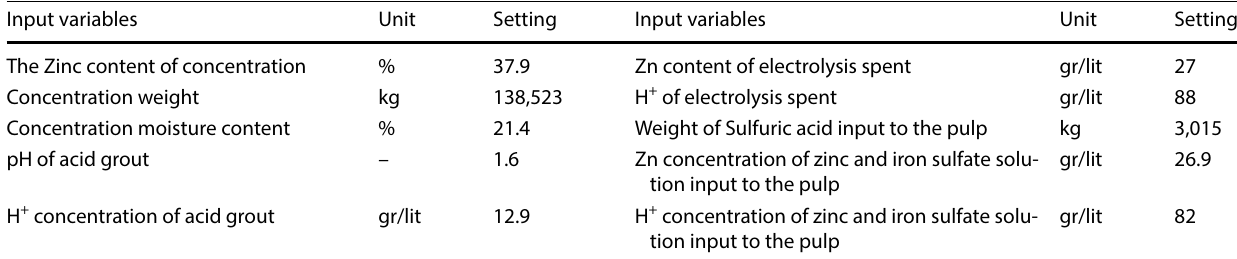
Table 16 Inputs setting for the second interval